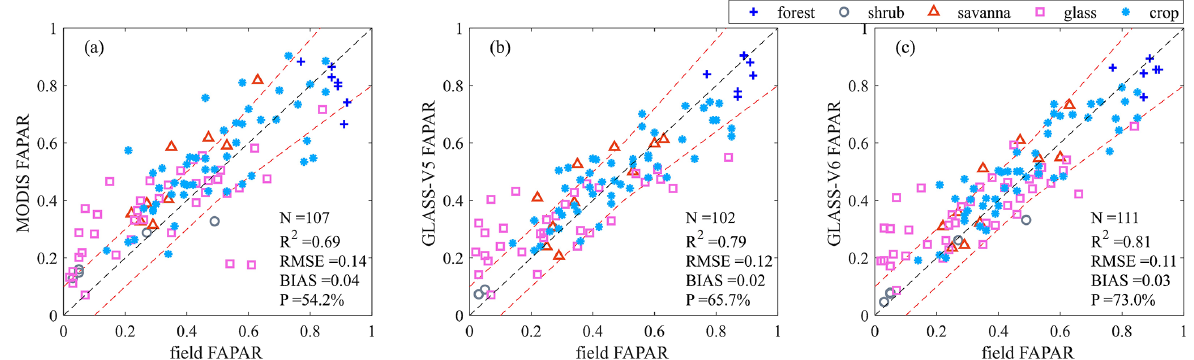
Figure 6. Direct validation of the (a) MODIS, (b) GLASS V5, and (c) GLASS V6 FAPAR products at the 3km scale using the DIRECT ground measurement dataset from 2000 to 2017. Table 2. Direct validation of the four FAPAR products at the 250m, 500m, and 3km scales using FAPAR reference maps from 2000 to 2016 for different biome